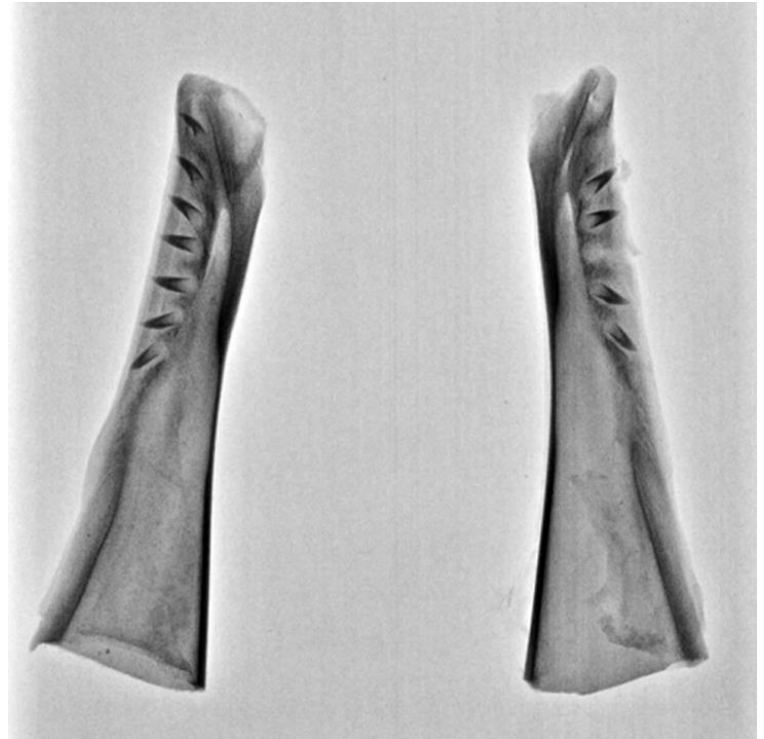
Fig. 1. X-ray of a beluga fetus mandible. HI-08-06 fetus. The right mandible was dissected in the field; the first, second, and fifth teeth (MNR-1, -2, and -5 respectively) are missing. The left mandible is intact; 7 teeth are present in the tooth row. All the teeth were embedded in the